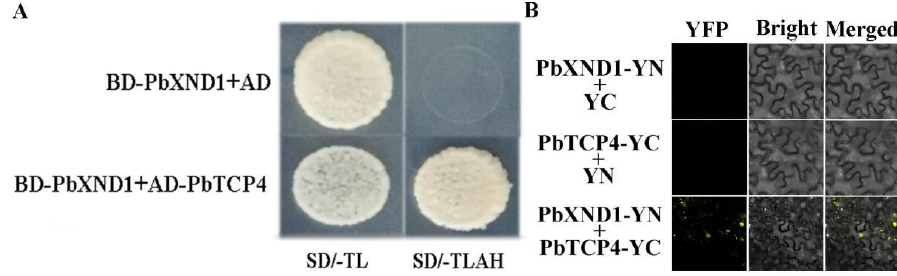
Figure 3. PbXND1 physically interacts with PbTCP4. ( A ) Protein interactions between PbXND1 and PbTCP4 were verified by the yeast two-hybrid method. ( B ) Bimolecular fluorescence comple- mentation (BiFC) demonstrated that PbXND1 interacts with PbTCP4 in vivo. Bars, 20 μm.